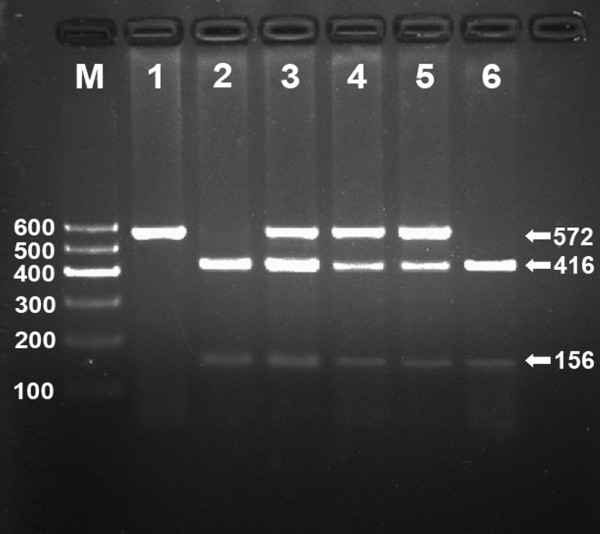
Genotyping of the TRIB1 rs17321515 SNP. Lane M, 100 bp marker ladder; lane 1, GG genotype (572 bp); lanes 2 and 6, AA genotype (416- and 156-bp); and lanes 3, 4 and 5, AG genotype (572-, 416- and 156-bp).